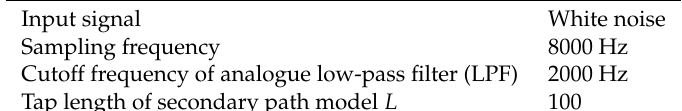
Table 2. Identification conditions of the secondary path.